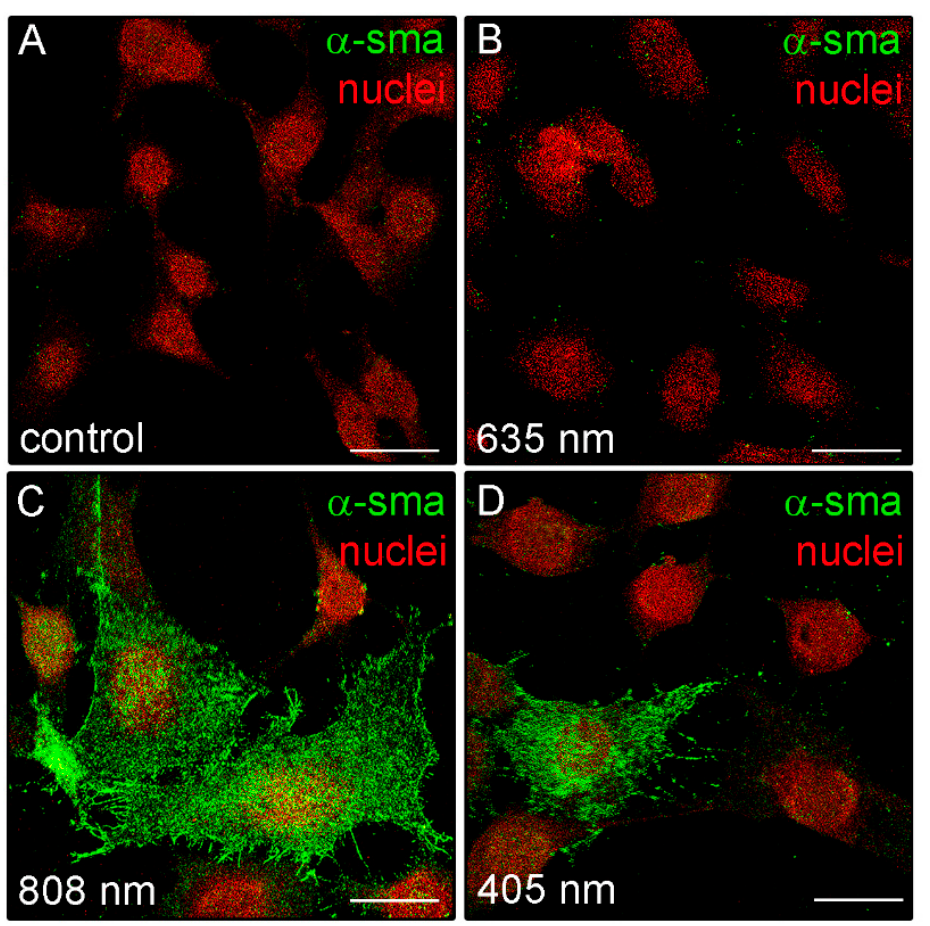
Figure 8. Confocal immunofluorescence analysis of α -sma expression in NIH/3T3 fibroblasts performed 24 h after cell exposure to red (635 nm), NIR (808 nm) and violet-blue (405 nm) PBM. ( A – D ) Representative confocal fluorescence micrographs of fixed cells immunostained to detect α -sma (green). Nuclei are marked in red with PI. Scale bar: 25 μ m.